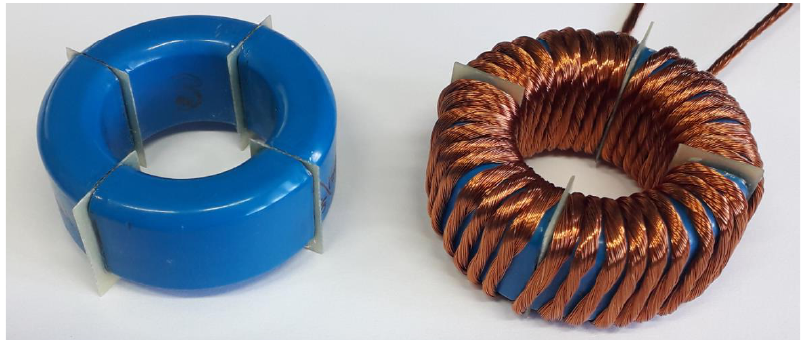
Figure 11. Alternative of the toroidal inductor with the distributed air gap without winding ( left ) and with winding ( right ).